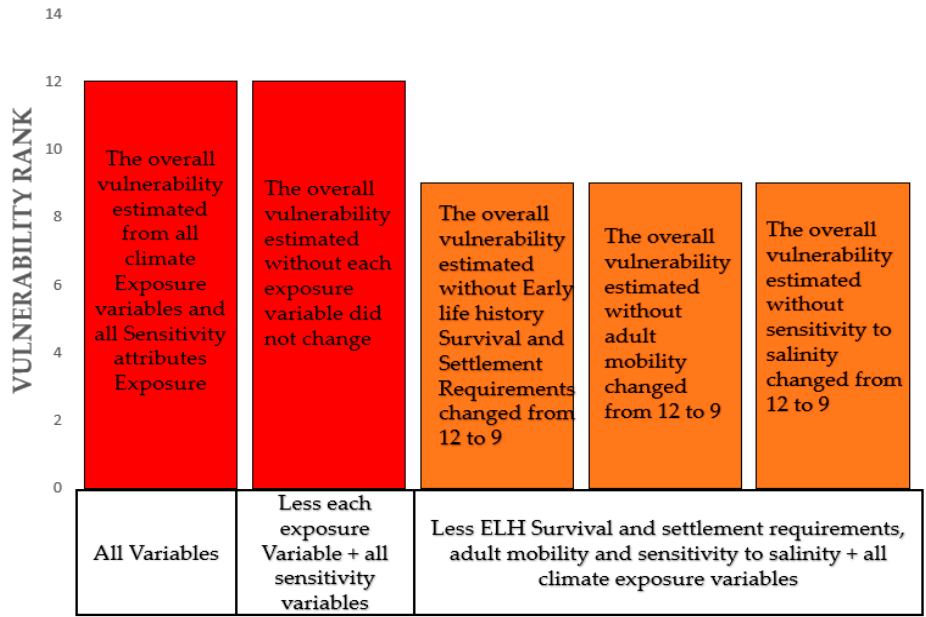
Figure 6. Importance of each factor’s contribution to the overall vulnerability rank of C. tulipa . Red denotes very high vulnerability; orange denotes high vulnerability.